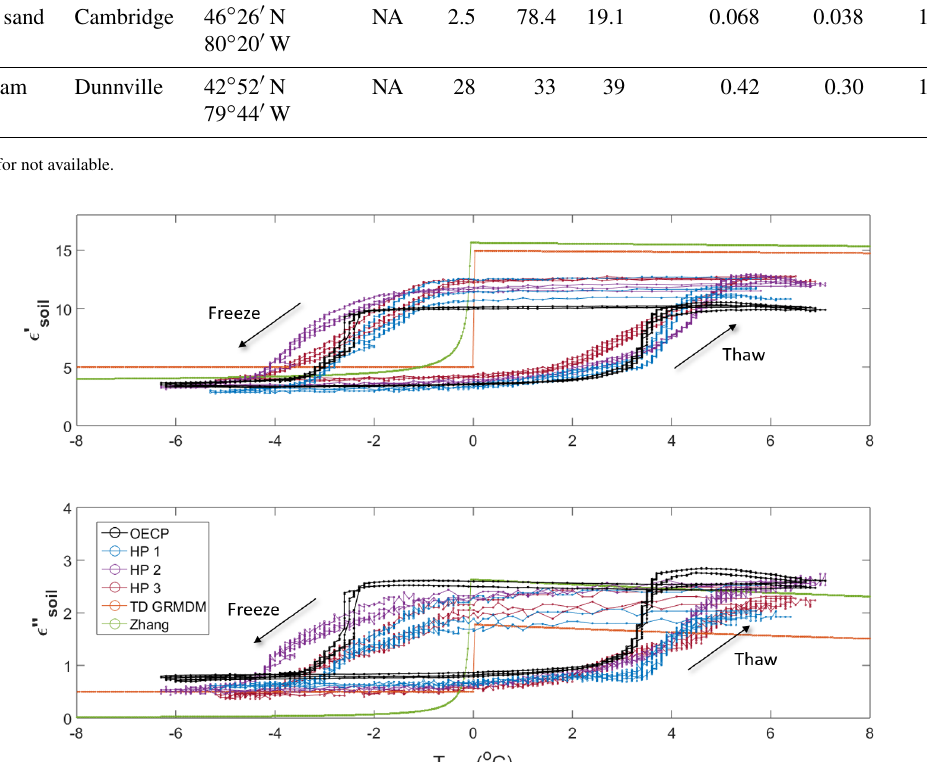
Figure 5. Real ( ε (cid:48) ) and imaginary ( ε (cid:48)(cid:48) ) permittivity of an organic soil sample from the Old Black Spruce site (see Table 1) during freeze–thaw cycles in a cold chamber environment. The OECP and HP instruments monitored soil permittivity, while TD GRMDM and Zhang are model results. The hysteresis effect displayed here is amplified by the experimental setup (discussed in the text). Experiment conducted from 1 to 7 February